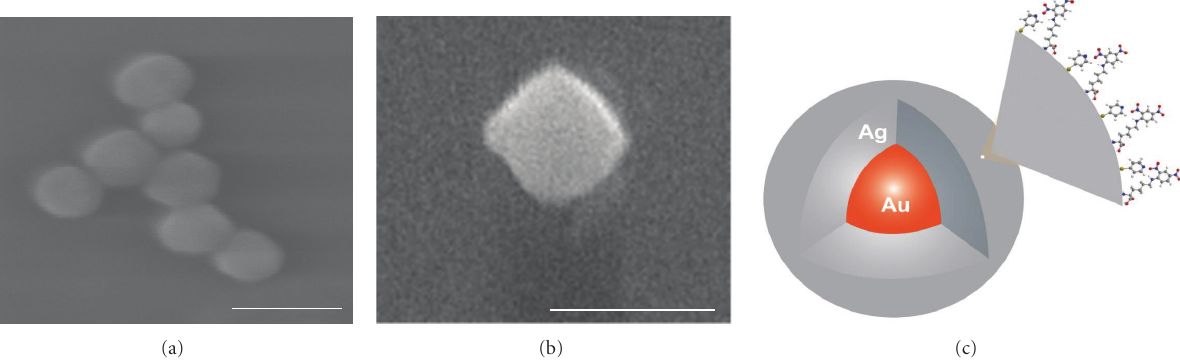
Figure 1: (a) Scanning electron microscope images of a few of the commercial Au colloidal particles. Scale bar is 60 μ m. (b) Composite SEM image of “developed” gold-silver core-shell colloidal particles. Ag layer varies from a few nm to a few 10s of nm in thickness, resulting in sizes varying from 70 to 150 nm. Scale bar is 100 μ m. (c) Schematic of the targeted nanosensor. Au@Ag nanoparticle with DNP and 4- MPy ligands, not drawn to scale. (a and b) Reprinted with permission from Nowak-Lovato et al. [11] (copyright 2009 Society for Applied